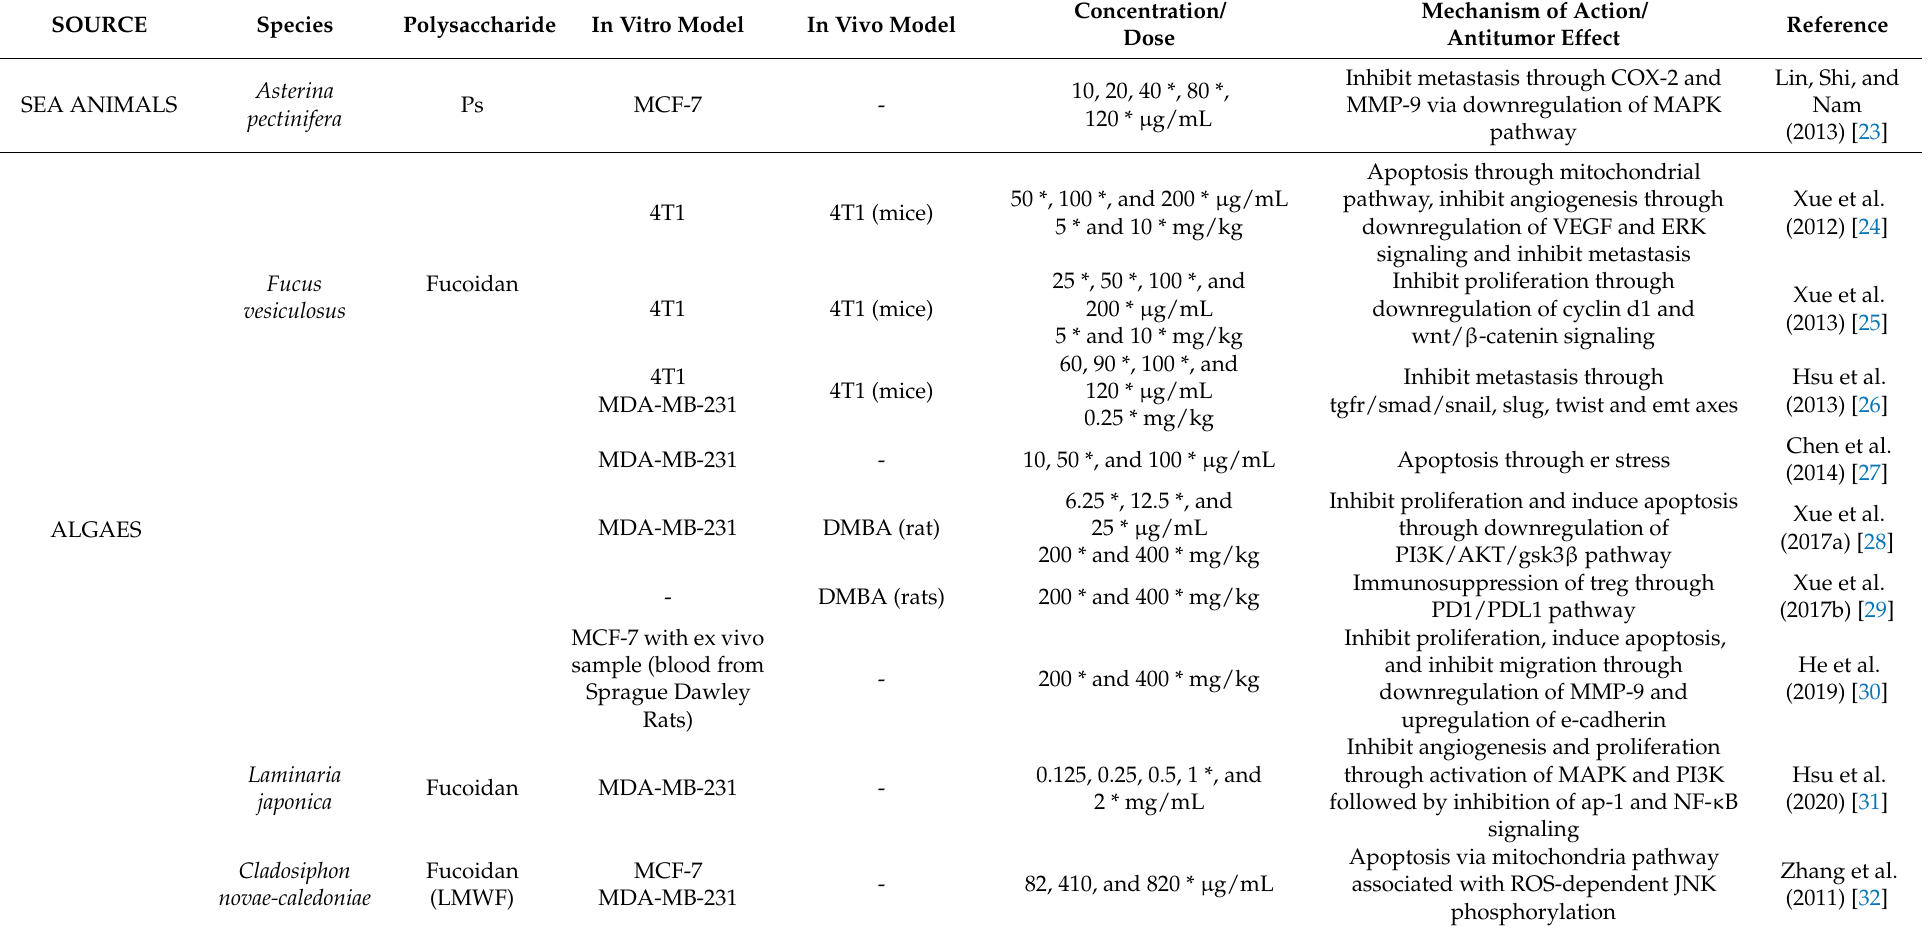
Table 2. Mechanism of action of different